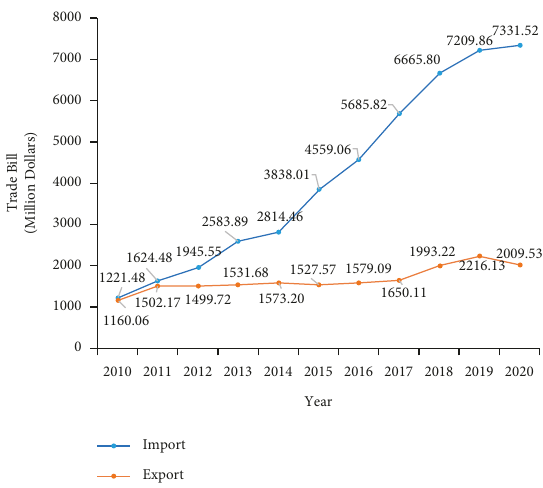
Figure 2: The total annual pastry import and export bill of China from 2010 to 2019.